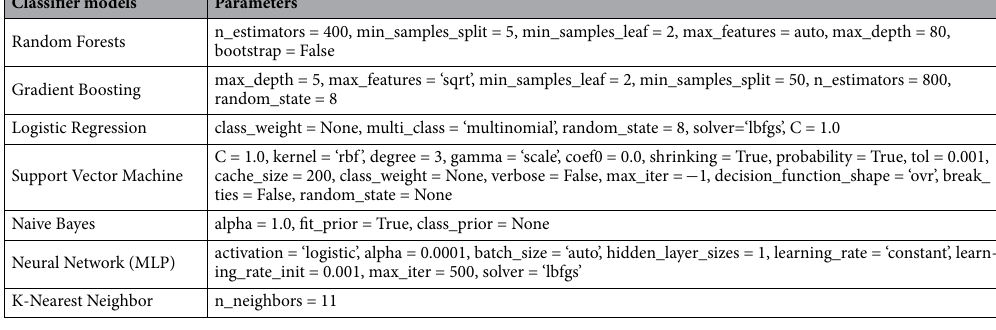
Table 3. The best tuned parameters of the